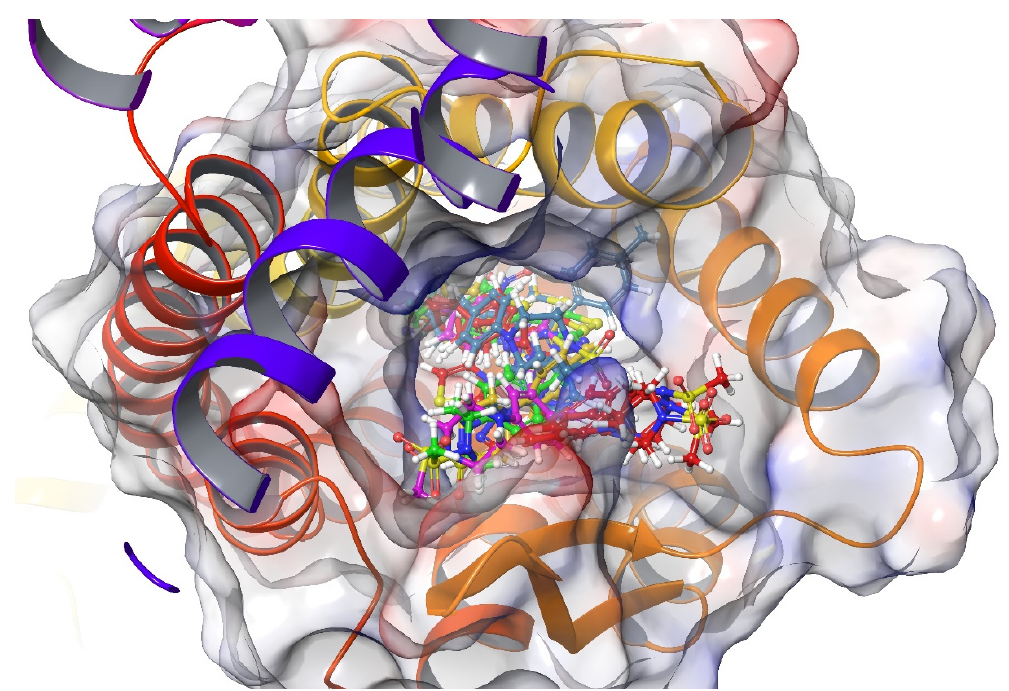
Molecules 2021 , 26 , x FOR PEER REVIEW Figure 15. The three-dimensional pose of the interaction of all compounds with the δ -opioid receptor (PDB Code:4N6H) active site. The inactive compounds ( 3d , 3e , and 3h ) are presented by a tube model colored with red.